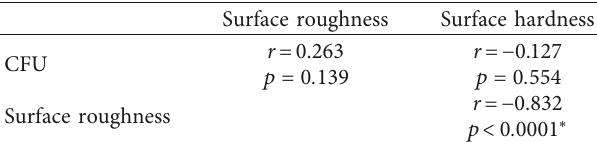
Table 2: Pearson correlation coefficients between C. albicans colony count and surface